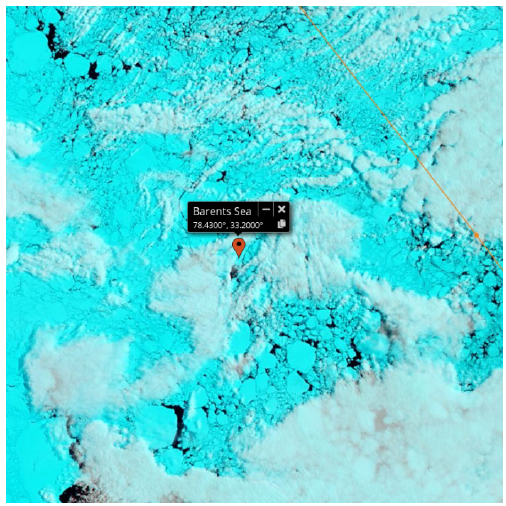
Figure C3. Same as Fig. C1, but for 26 June 2017. Image obtained from EOSDIS Worldview 2021 Version